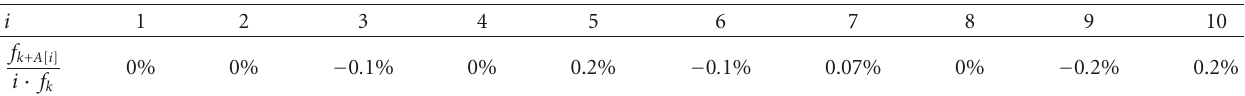
Table 1: Deviation between approximate and ideal values of the pitch energy spectrum. A [10] = [0, 120, 190, 240, 279, 310, 337, 360, 380,